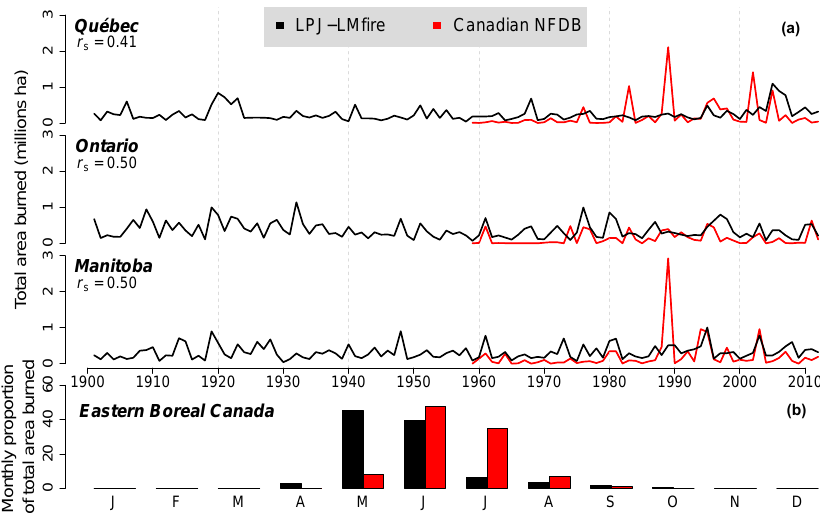
Figure 3. (a) Observed versus simulated total annual areas burned in three provinces of eastern Canada. Observed data (1959 to 2012) are from the Canadian National Fire Database (CNFDB). Spearman’s rank correlation between data is shown (correlations are significant at P <0.05 for Québec and P <0.001 for the other provinces). (b) Monthly percentage of total areas burned between 1959 and 2012 in eastern boreal